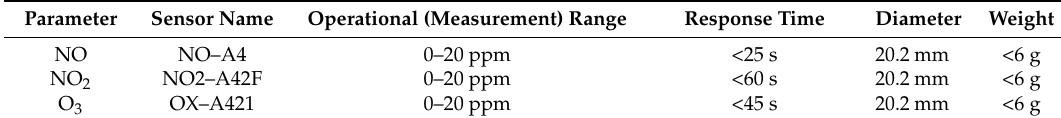
Table 1. Specifications of the Alphasense electrochemical microsensors [57].